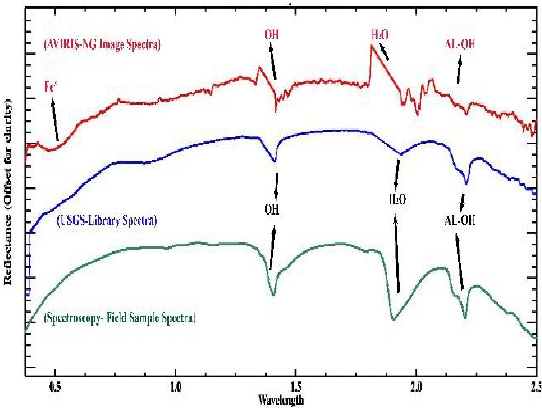
Figure 3: Spectral features of kaosmec and goethite